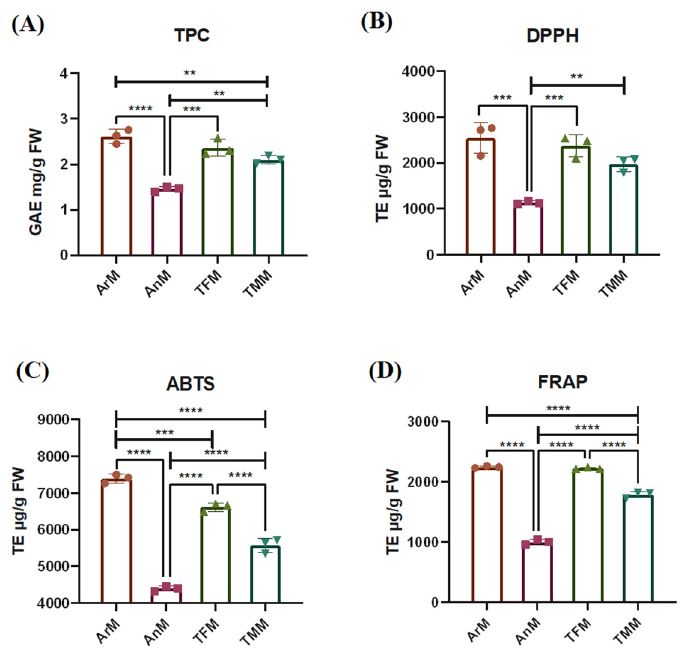
Figure 4. Total phenolic acids content and antioxidant activities of four parts from M. polymorpha . ( A ) Total phenolic acids content (TPC); ( B ) 2,2-diphenyl-1-picrylhydrazyl radical scavenging ability (DPPH); ( C ) 2,2 (cid:48) -azino-bis(3-ethylbenzothiazoline-6-sulfonic) acid radical scavenging activity (ABTS); ( D ) Ferric reducing antioxidant power (FRAP). GAE: gallic acid equivalent; TE: Trolox equivalent;